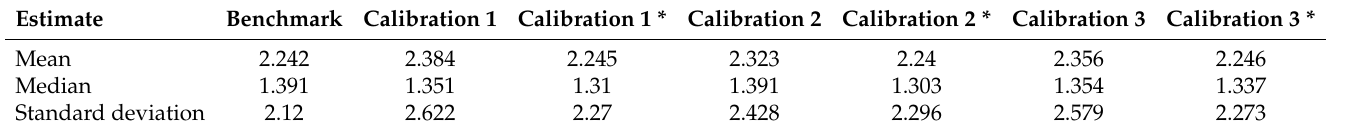
Table 3. Mean values for estimates of HIV onward transmissions from the master model and after calibration with features from HIV epidemiology and sexual behaviour (Calibration 1), a phylogenetic tree (Calibration 2), and a combination of the two types of features (Calibration 3).